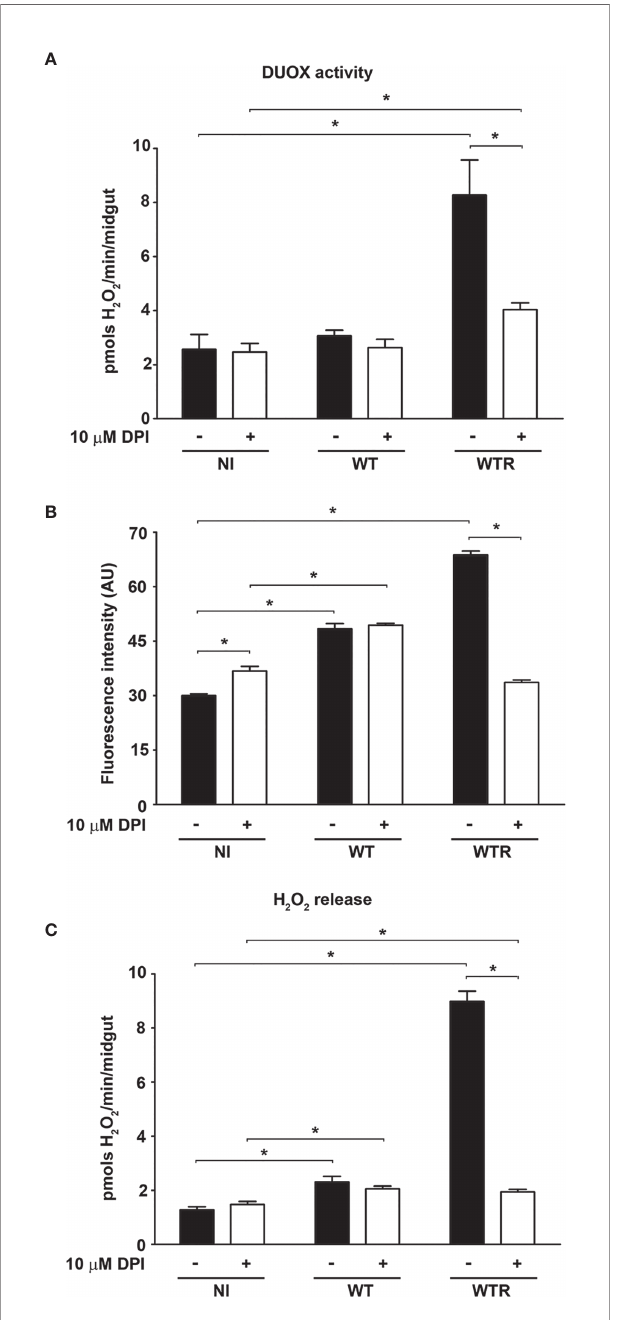
FIGURE 2 | Strigomonas culicis hydrogen peroxide (H 2 O 2 )-resistant (WTR) strain stimulates dual oxidase (DUOX)-dependent H 2 O 2 production during Aedes aegypti infection. Analysis was performed in midguts of non-infected (NI), wild-type (WT)- and WTR-infected females fed with 10% sucrose or 10% sucrose + 10 µM diphenylene iodonium (DPI) ad libitum 4 dpi. (A) Ionomycin- derived DUOX activity (*p = 0.05). Enzyme activity was performed through the production of H 2 O 2 in midguts incubated with 1 µM ionomycin (pools of 20 guts). (B) Quantitative analysis of fl uorescence microscopy (*p = 0.001). Individual analysis of 10 – 15 midguts per group. (C) Total H 2 O 2 production measurement (*p = 0.05). Signi fi cant p-values were obtained by Mann – Whitney test, and error bars represent the mean ± SEM of at least three independent experiments.